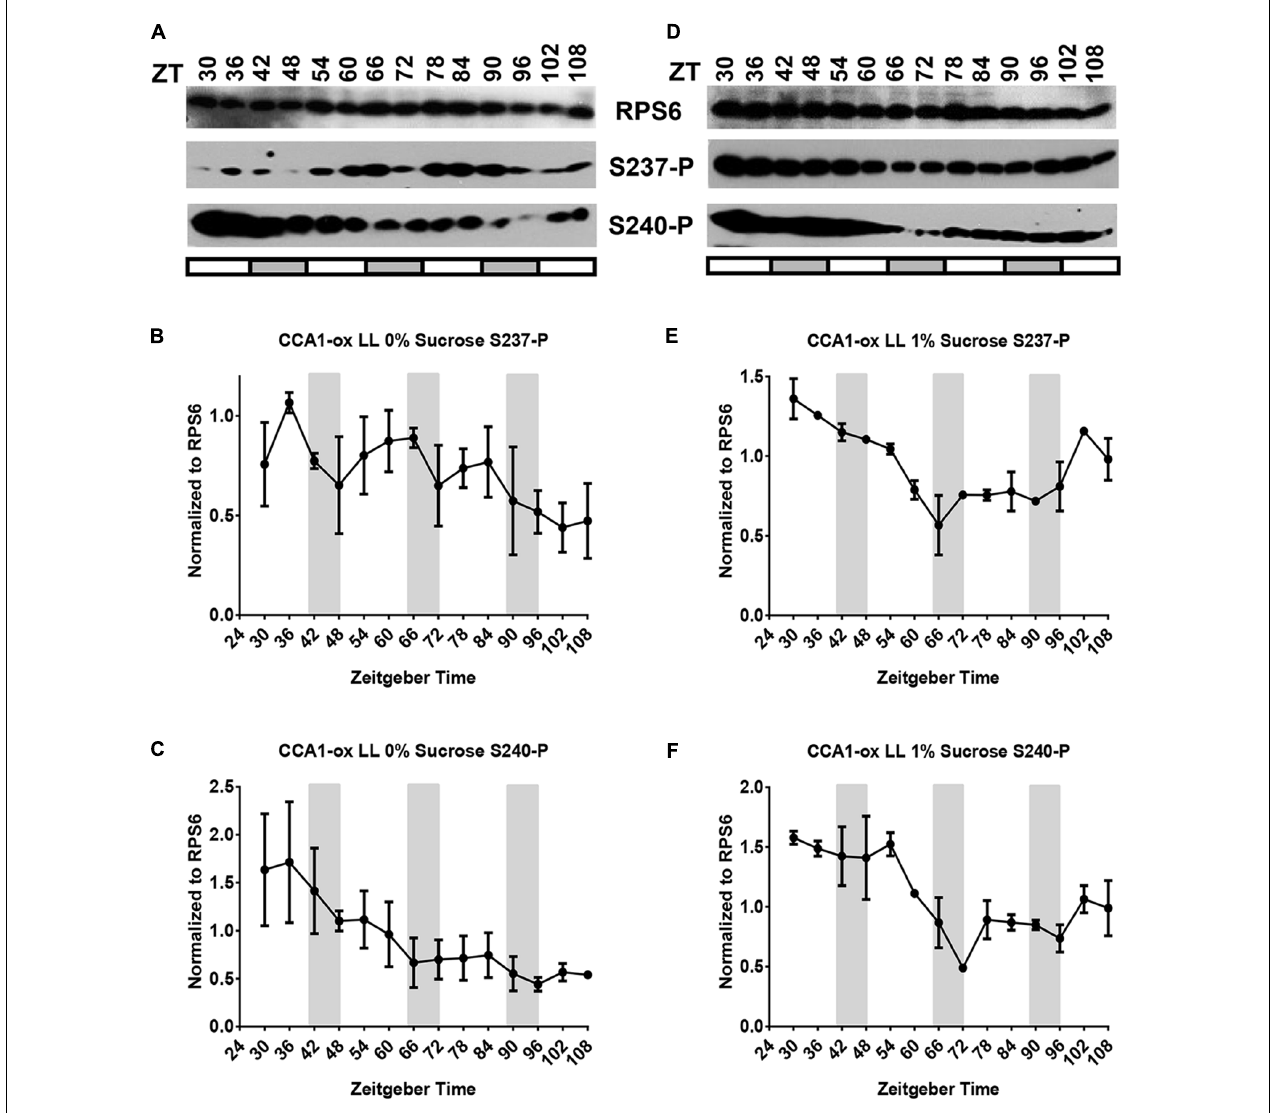
FIGURE 4 | The CCA1-ox strain cannot sustain cycles of RPS6 phosphorylation if grown in continuous light. Seedlings of clock-deficient Arabidopsis (CCA1-ox) were entrained in a light-dark cycle for 11 days, then shifted to continuous light for another four and a half days. Sampling began at ZT30 on the second day in continuous light. Seedlings were grown on medium lacking sucrose (A–C) or containing 1% sucrose (D–F) . (A,D) Representative immunoblots for S237-P and S240-P and total RPS6. (B,C,E,F) Immunoblot signals for S237-P and S240-P were quantified and normalized against total RPS6 signals from the same time point, followed by median-centering each data series and averaging of the multiple replicates. Error bars show the standard error of the mean from n = 2